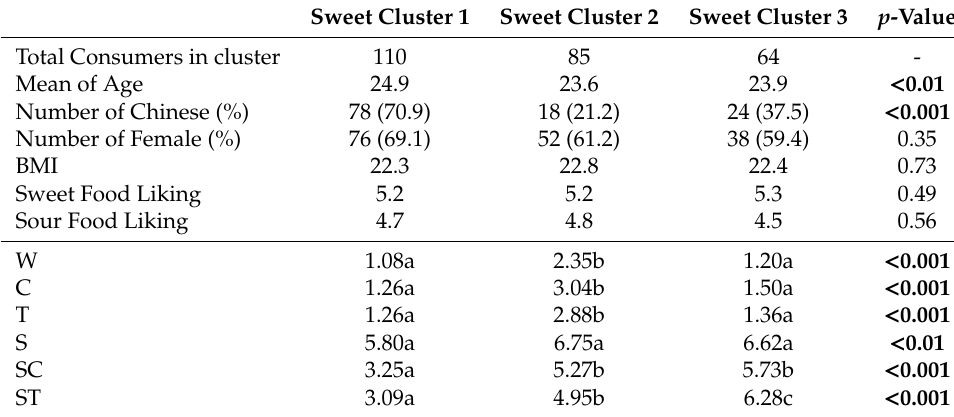
Table 6. Cluster characteristics and means of ratings for Sweetness in Sweet clusters. Samples are Water (W), Citric acid (C), Tartaric acid (T), Sucrose (S), Sucrose and Citric acid (SC), and Sucrose and Tartaric acid (ST). P -values for cluster culture and gender are for χ 2 analysis of di ff erence, whereas p -values for Age, BMI, and Sweet and Sour Food Liking are from ANOVA. P -values for Sweetness Intensity are derived from mixed model Analysis of Variance. Letters are to be read row wise, and indicate significant di ff erences between samples based on Honest Significant Di ff erences (HSD). Note that, even though the Analysis of Variance find significant di ff erences between clusters for sample S, HSD fail to identify di ff erences. Significant e ff ects ( p ≤ 0.05) are marked in